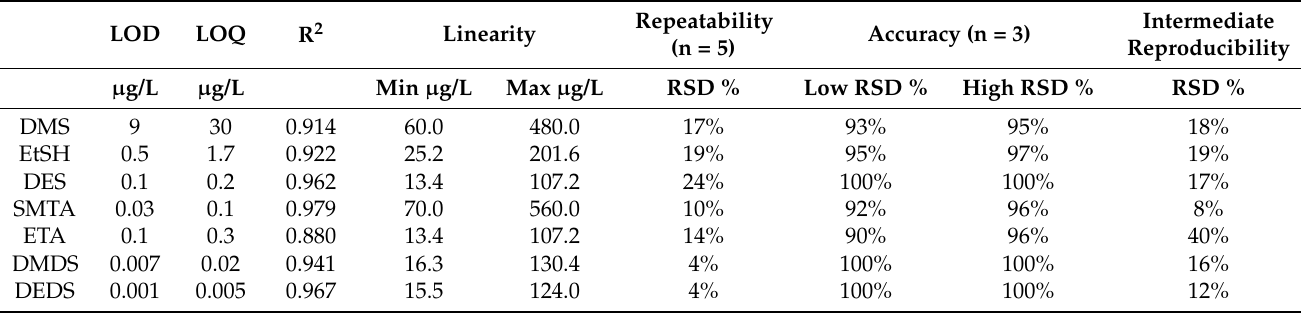
Table 3. Analytical performances for the 7 VSC analyzed (LOD: limit of detection; LOQ: limit of quantification; R 2 ; linearity; repeatability; accuracy; intermediate